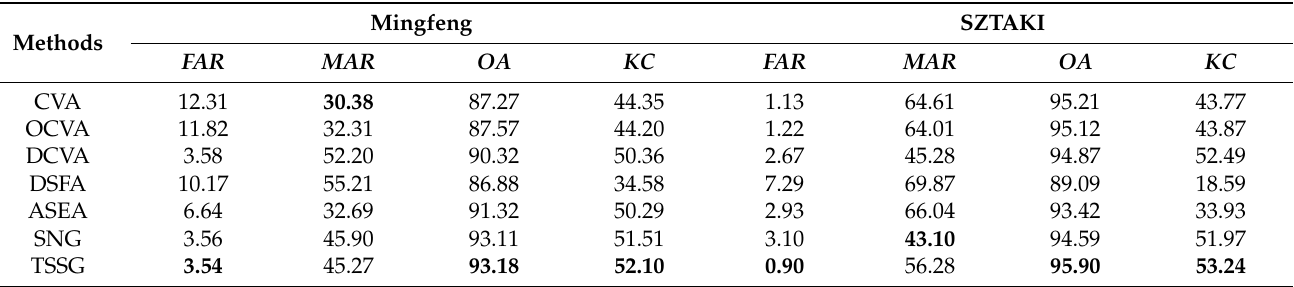
Table 2. Quantitative accuracy results for different methods on Mingfeng and SZTALI data sets (The best ones are shown by bold).